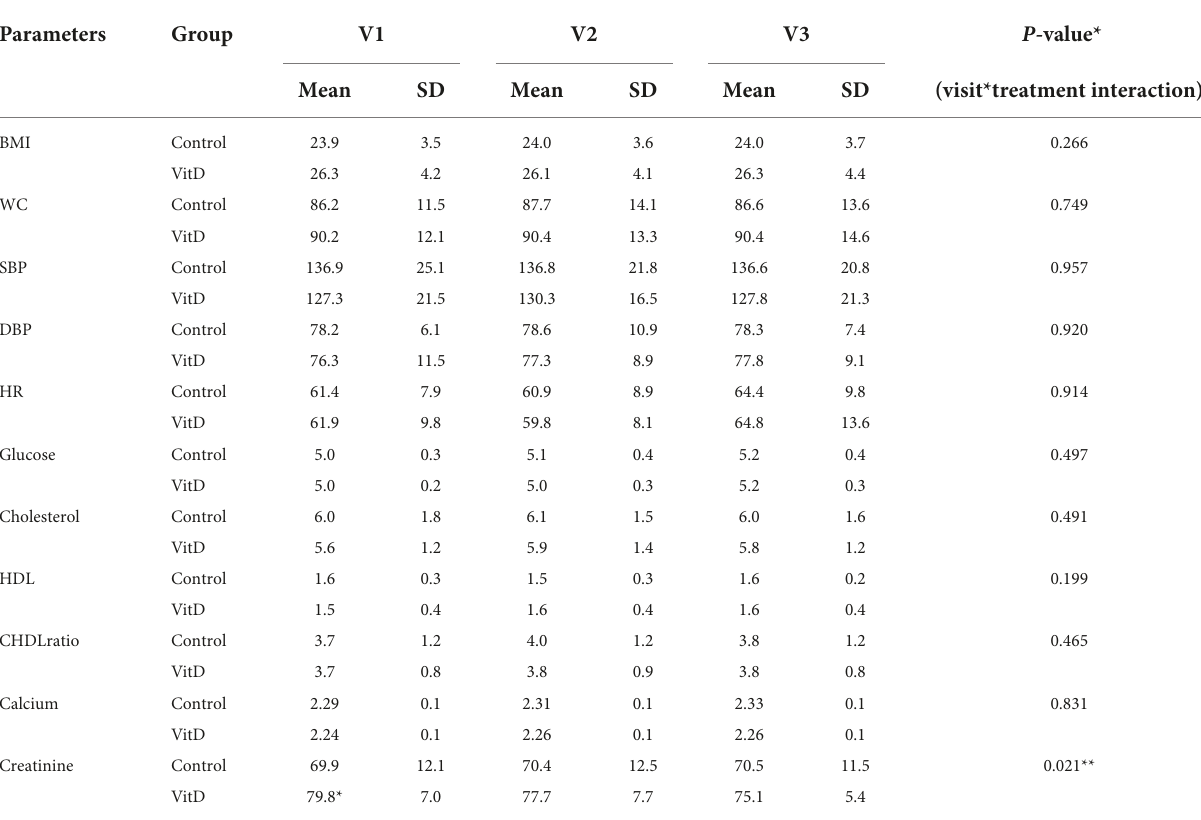
TABLE 6 Metabolic parameters at different visits of the